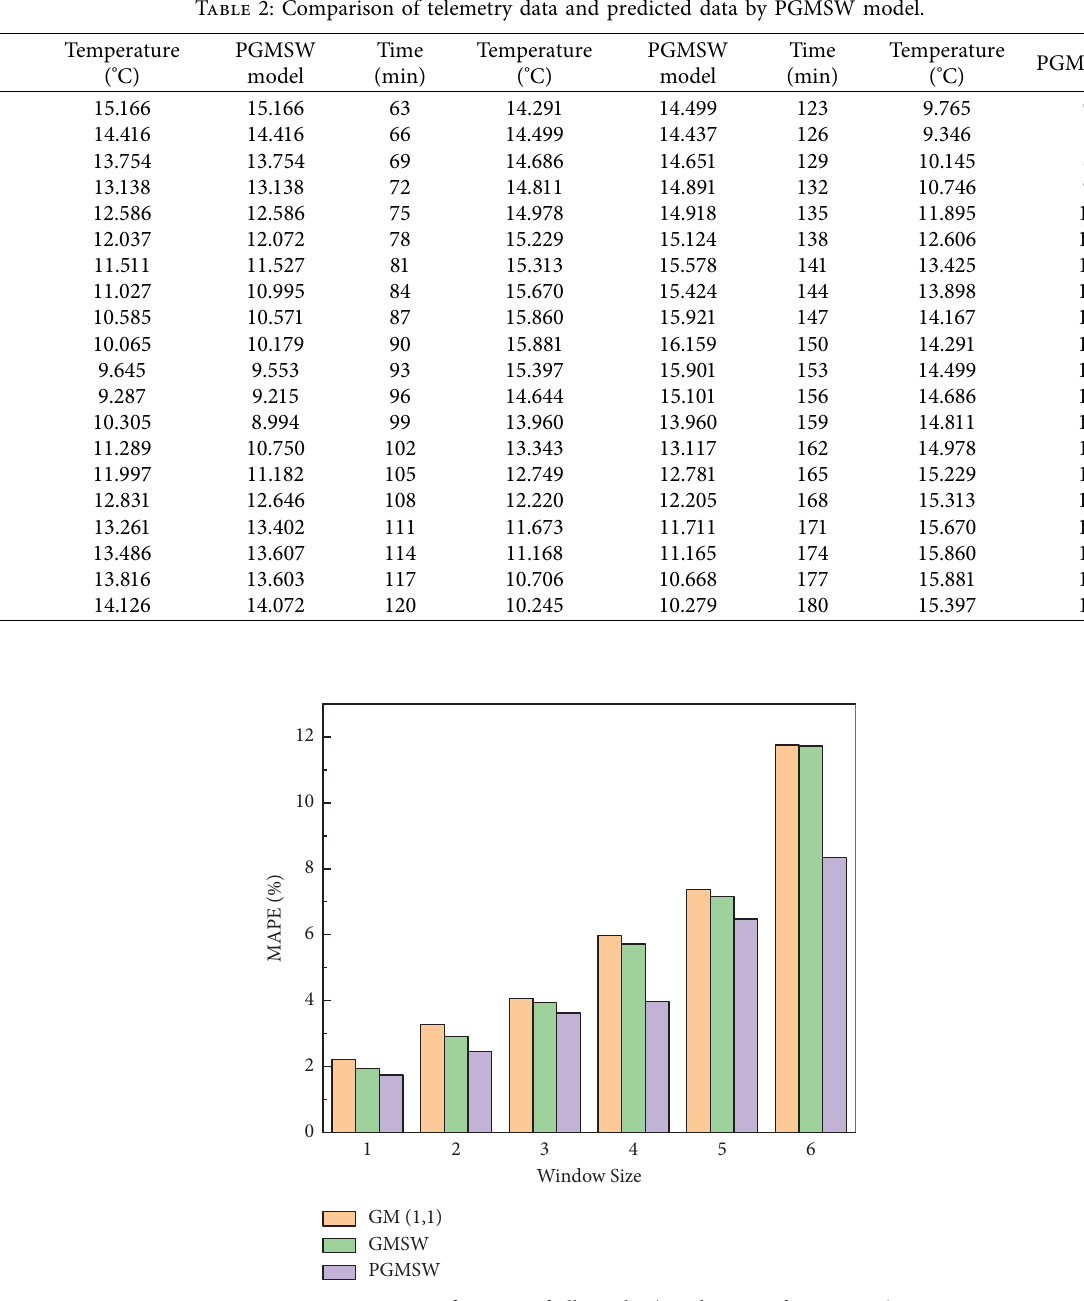
Figure 6: Comparison of MAPE of all results (window size from 1 to